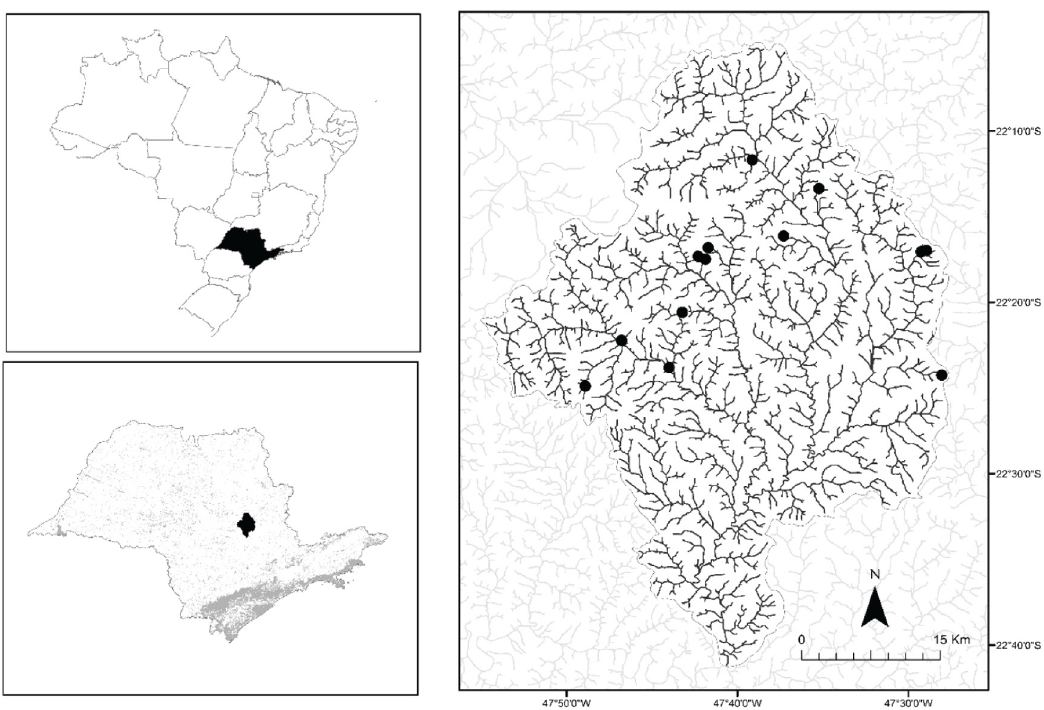
Figure 1. Sampling points of ichthyofauna in 13 headwaters distributed among four rivers: Cabeça, Corumbataí, Passa Cinco e Ribeirão Claro, in the Rio Corumbataí River Basin, São Paulo State, southeastern Brazil. Black dots represent the sampling